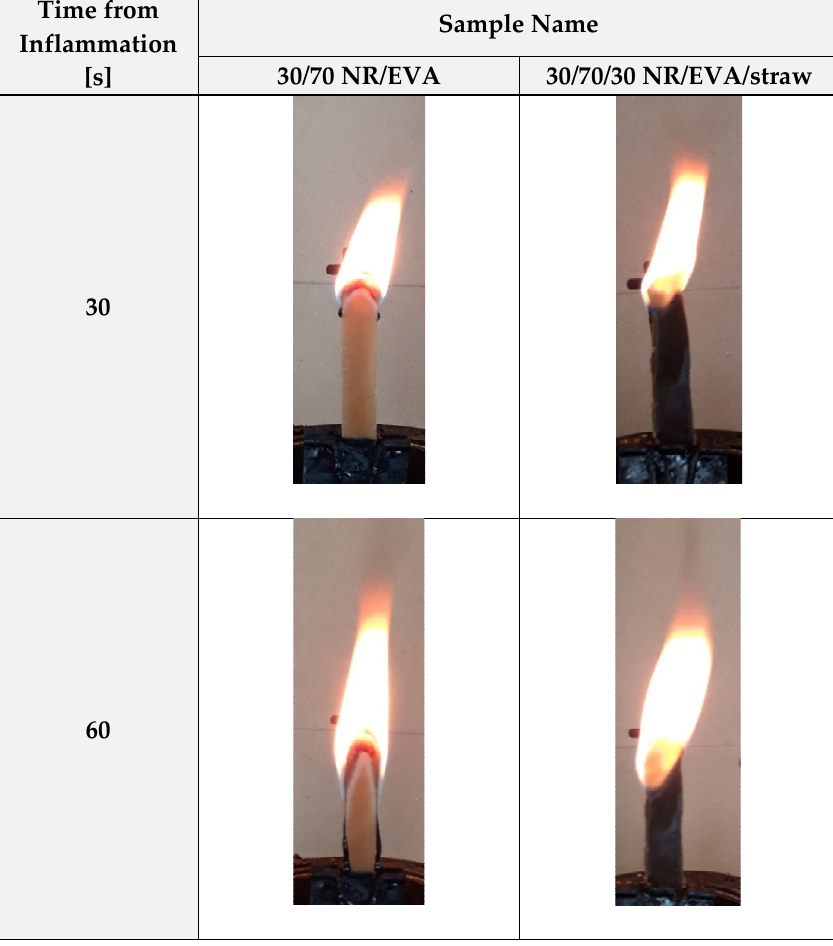
Figure 6. The comparison of sample behavior during combustion for 30/70 NR/EVA (unfilled and filled with 30 phr